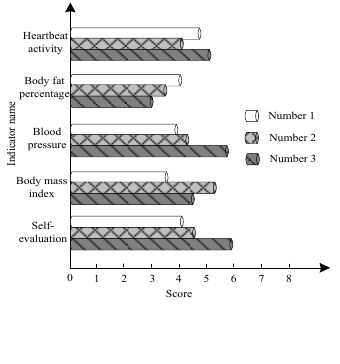
Figure 5. Evaluation results of the first-level indicators